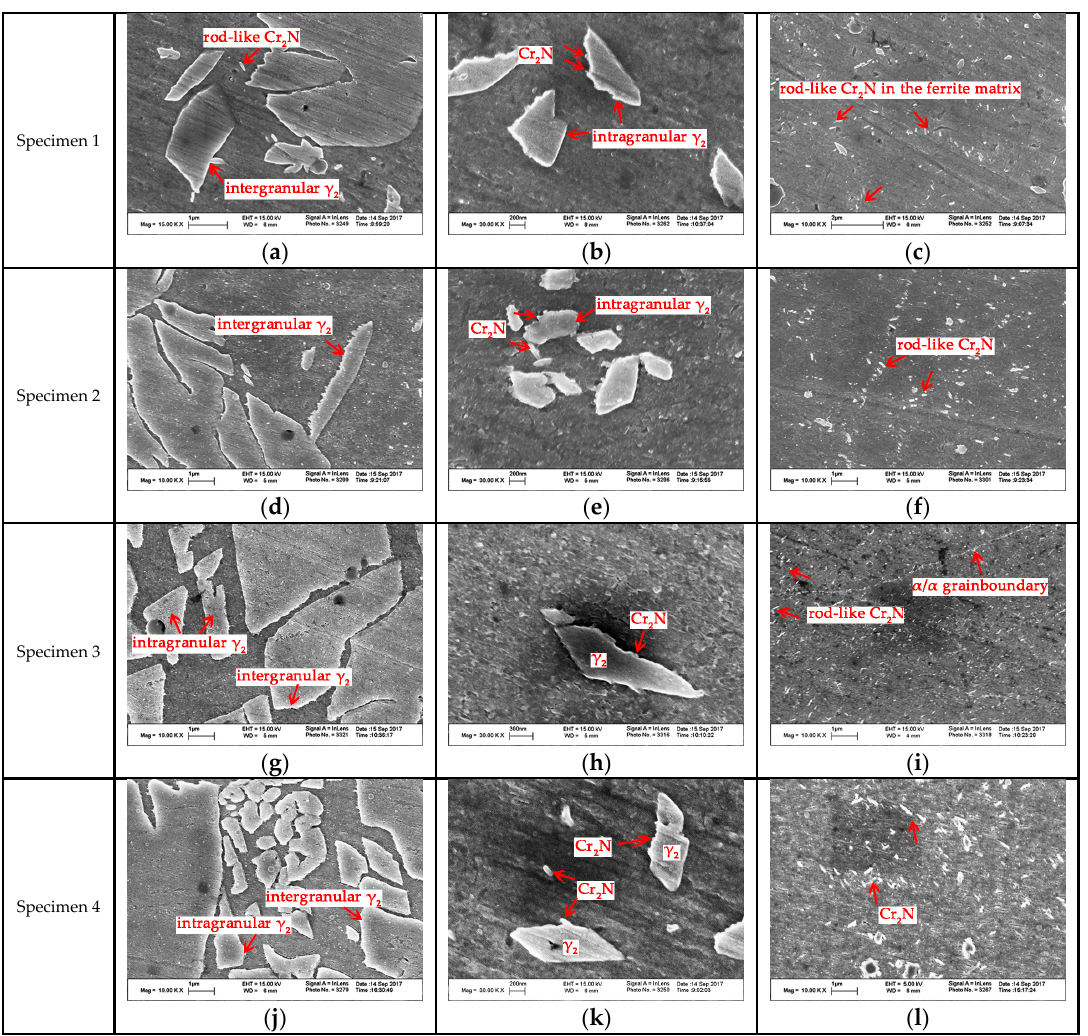
Figure 8. SEM graphs of γ 2 and Cr 2 N in each specimen: ( a – c ) of Specimen1; ( d – f ) of Specimen 2; ( g – i ) of Specimen 3 and ( j – l ) of Specimen 4.